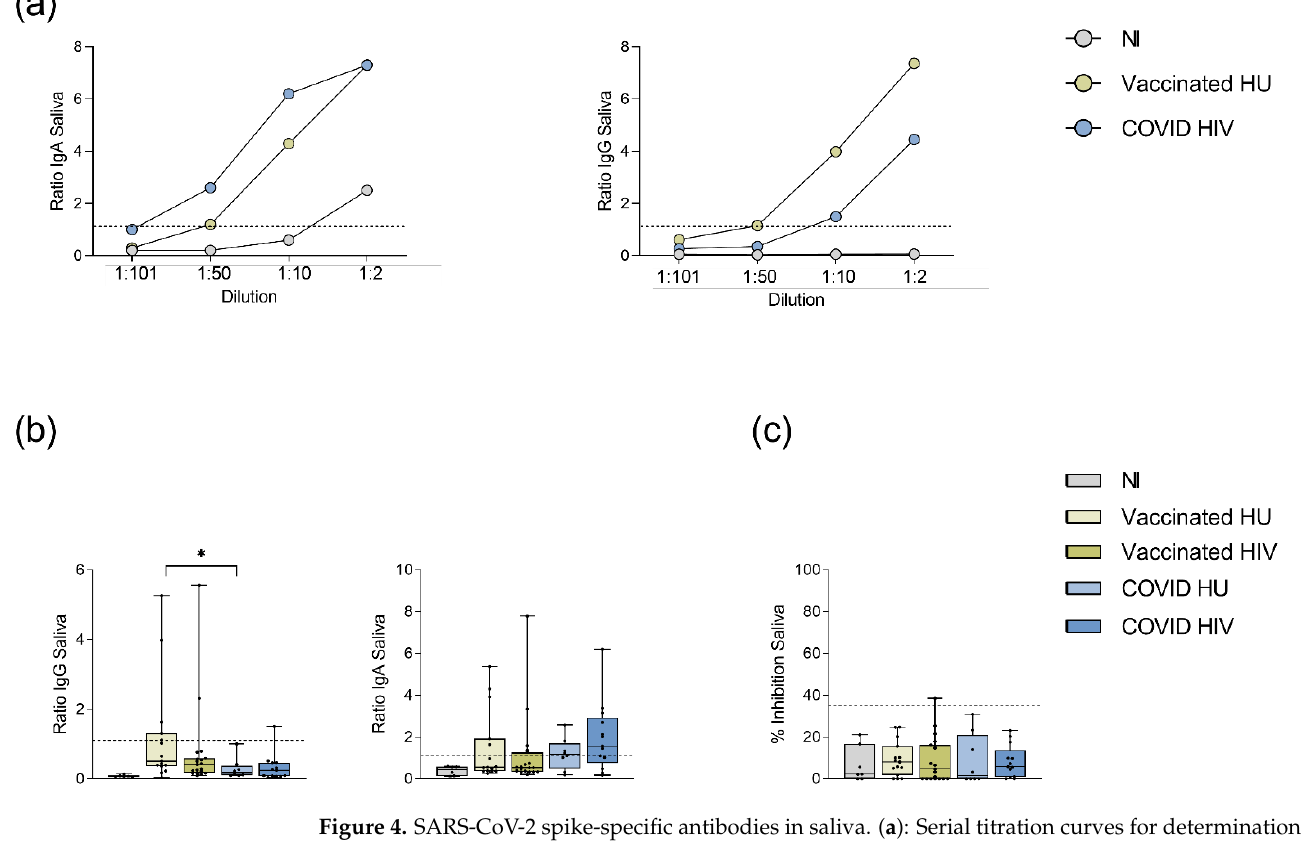
Figure 4. SARS-CoV-2 spike-specific antibodies in saliva. ( a ): Serial titration curves for determination of spike-specific IgA and IgG antibodies in saliva, n = 1 each. ( b ): Spike-specific IgG and IgA antibody levels in the saliva of BNT162b2 mRNA vaccinees and COVID-19 convalescent donors given as antibody ratios obtained by dividing the extinction of the sample by that of the calibrator. All vaccinated ( p ≤ 0.001) and convalescent groups ( p ≤ 0.030) had significantly higher spike-specific IgG levels in saliva than the NI group. Only convalescent subjects had significantly higher saliva anti-spike IgA levels above the NI group ( p ≤ 0.029). The cut-off ratio for a positive result at ≥ 1.1 is indicated by the dashed line. ( c ): Except for one individual, no neutralizing capacity against SARS- CoV-2 could be detected in saliva at a 1:5 dilution. The cut-off for positive neutralization capacity (≥35% inhibition) is indicated by the dashed line. SARS-CoV-2 non-immune (NI, n = 6), vaccinated HIV-1-uninfected (HU, n = 15), vaccinated HIV-1-infected (HIV, n = 19), COVID-19 HIV-1-uninfected (COVID HU, n = 8), COVID-19 HIV-1-infected (COVID HIV, n = 13). Significance was tested by Mann – Whitney U tests. * = p ≤ 0.05. Medians and IQRs are presented. Table 8. Normalized saliva anti-spike IgG and IgA levels n IgG +